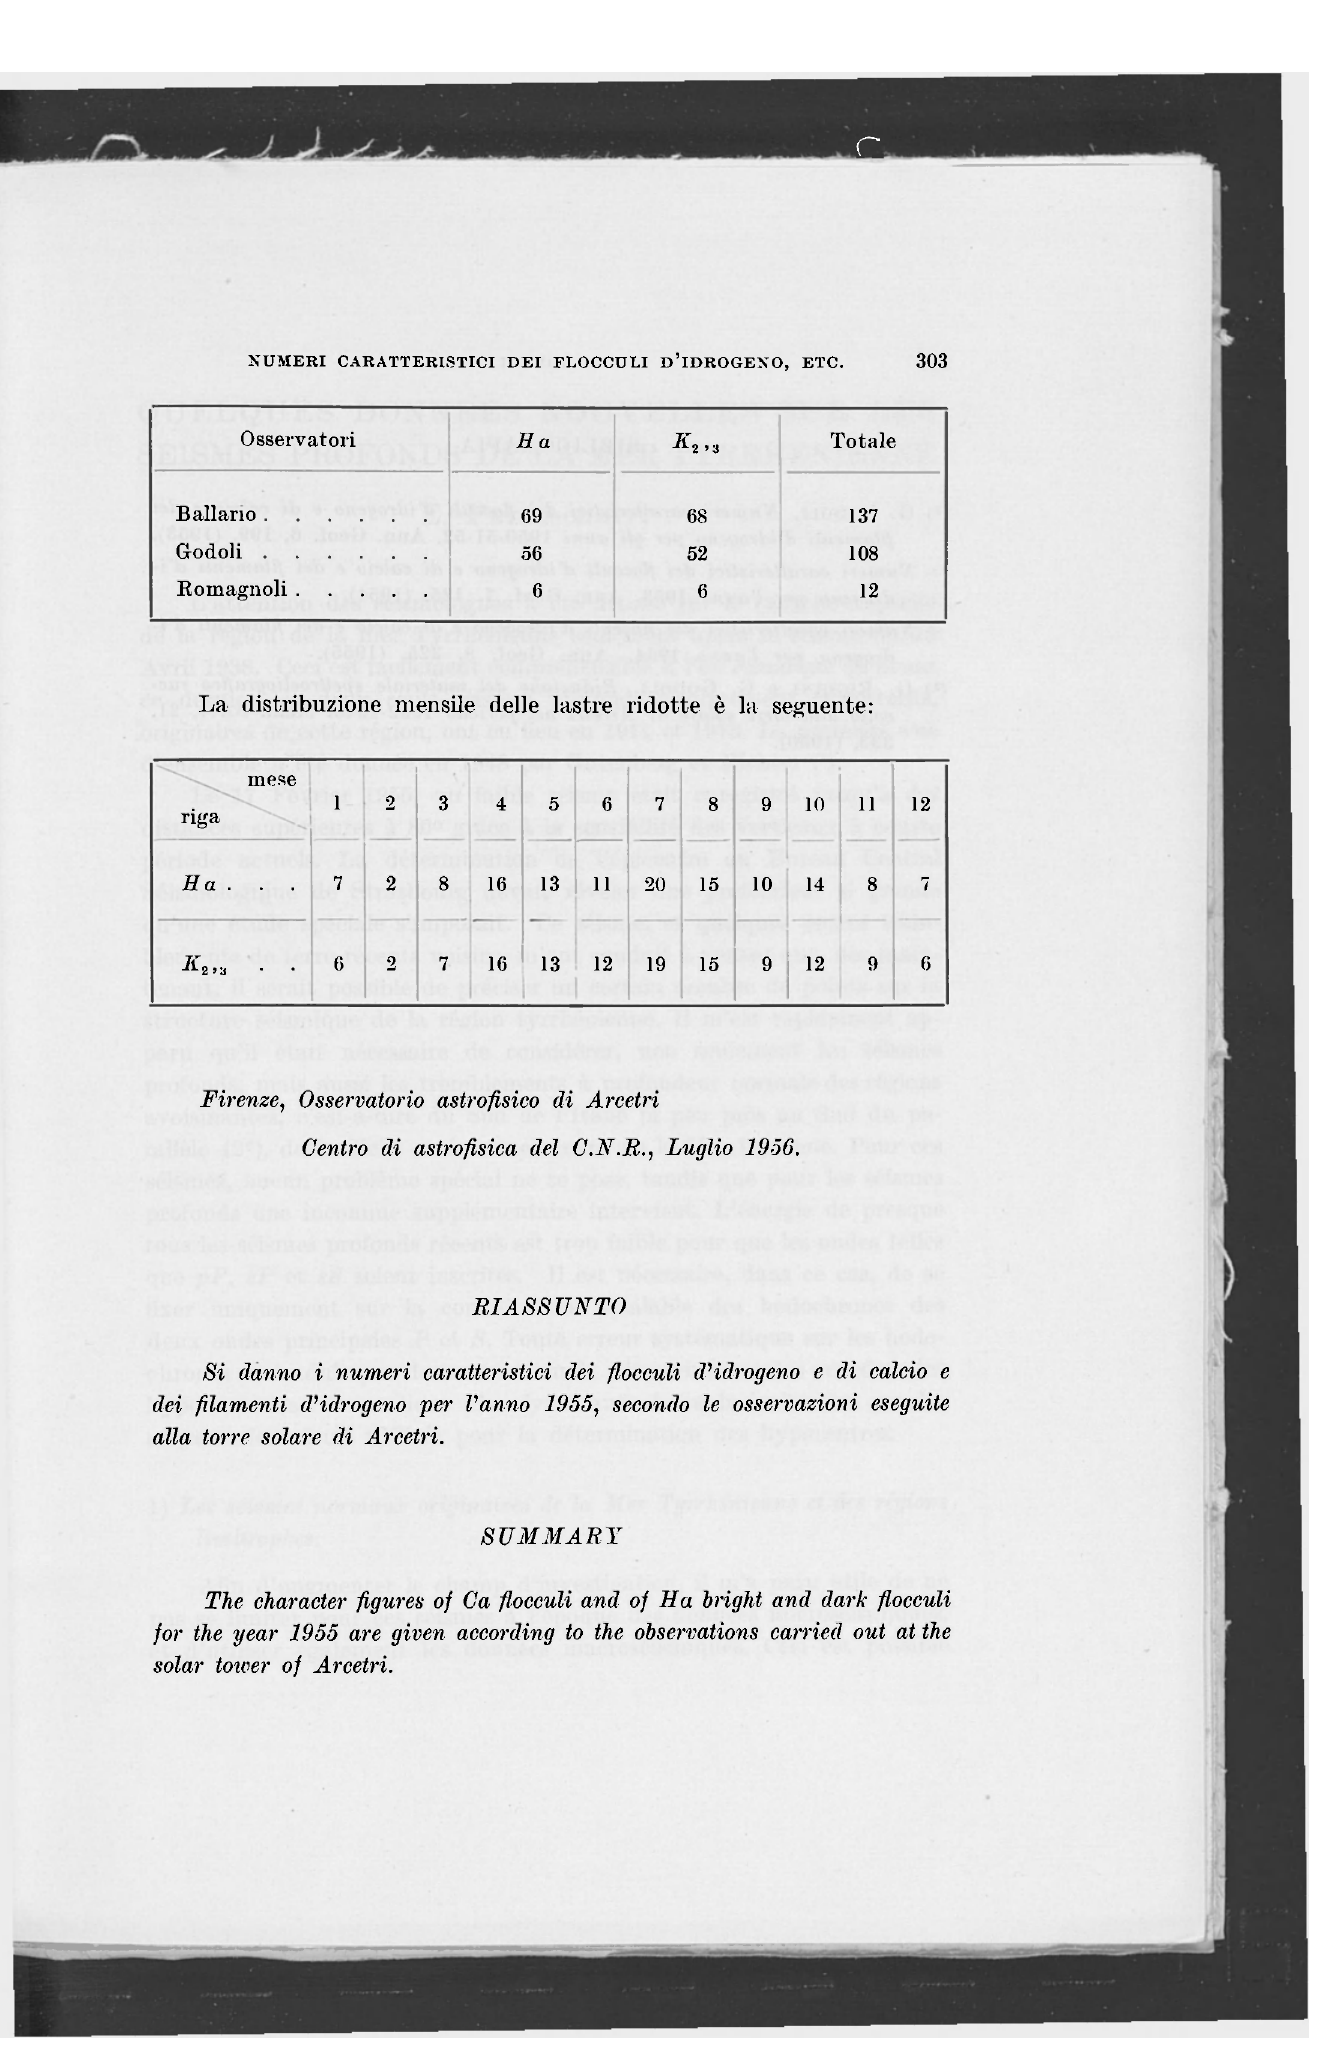
dei filamenti d'idrogeno per l'anno 1955, secondo le osservazioni eseguite alla torre solare di